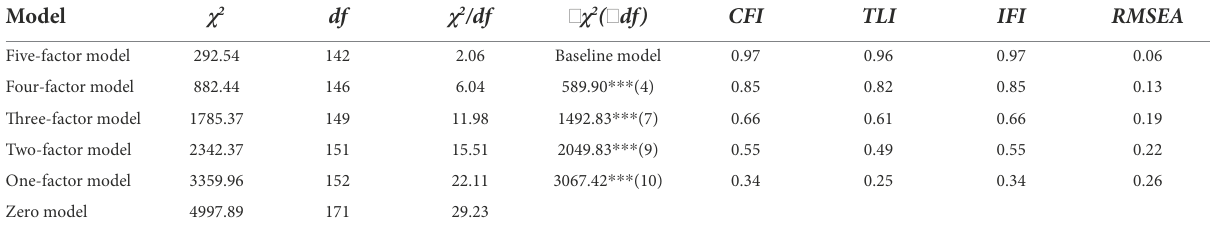
TABLE 2 Results of confirmatory factor analysis.